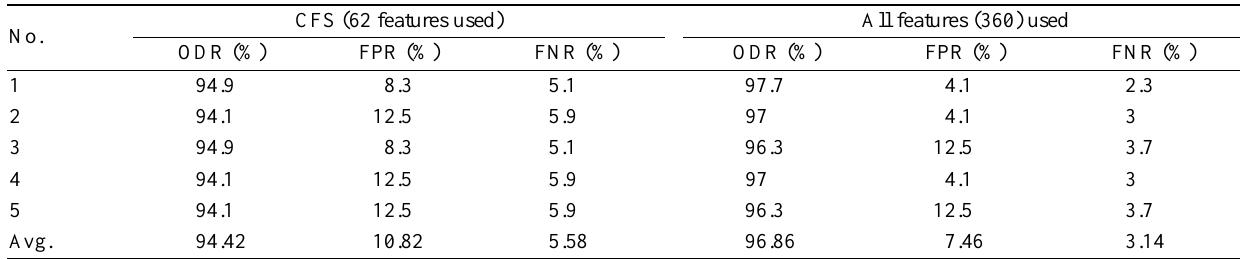
All features (360) used